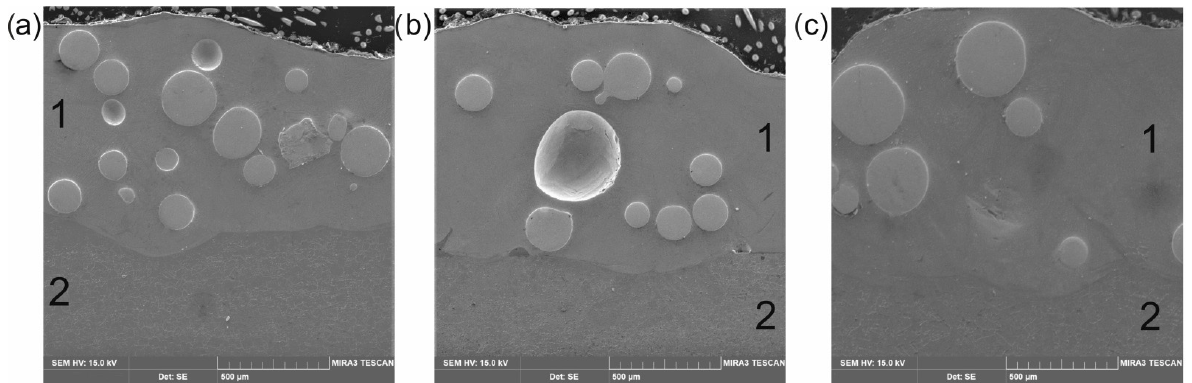
Figure 3. SE images of the microstructure of Inconel ® 600-alloy after laser surface alloying using a laser beam power of: ( a ) 1.3 kW, ( b ) 1.56 kW, ( c ) 1.82 kW. 1—laser-alloyed layer (re-melted zone); 2—substrate material.